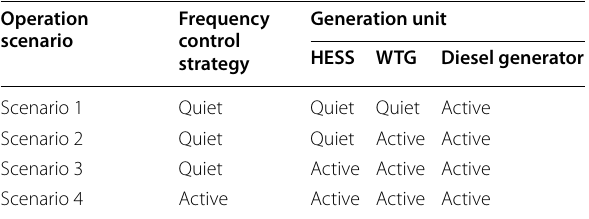
Table 1 The different